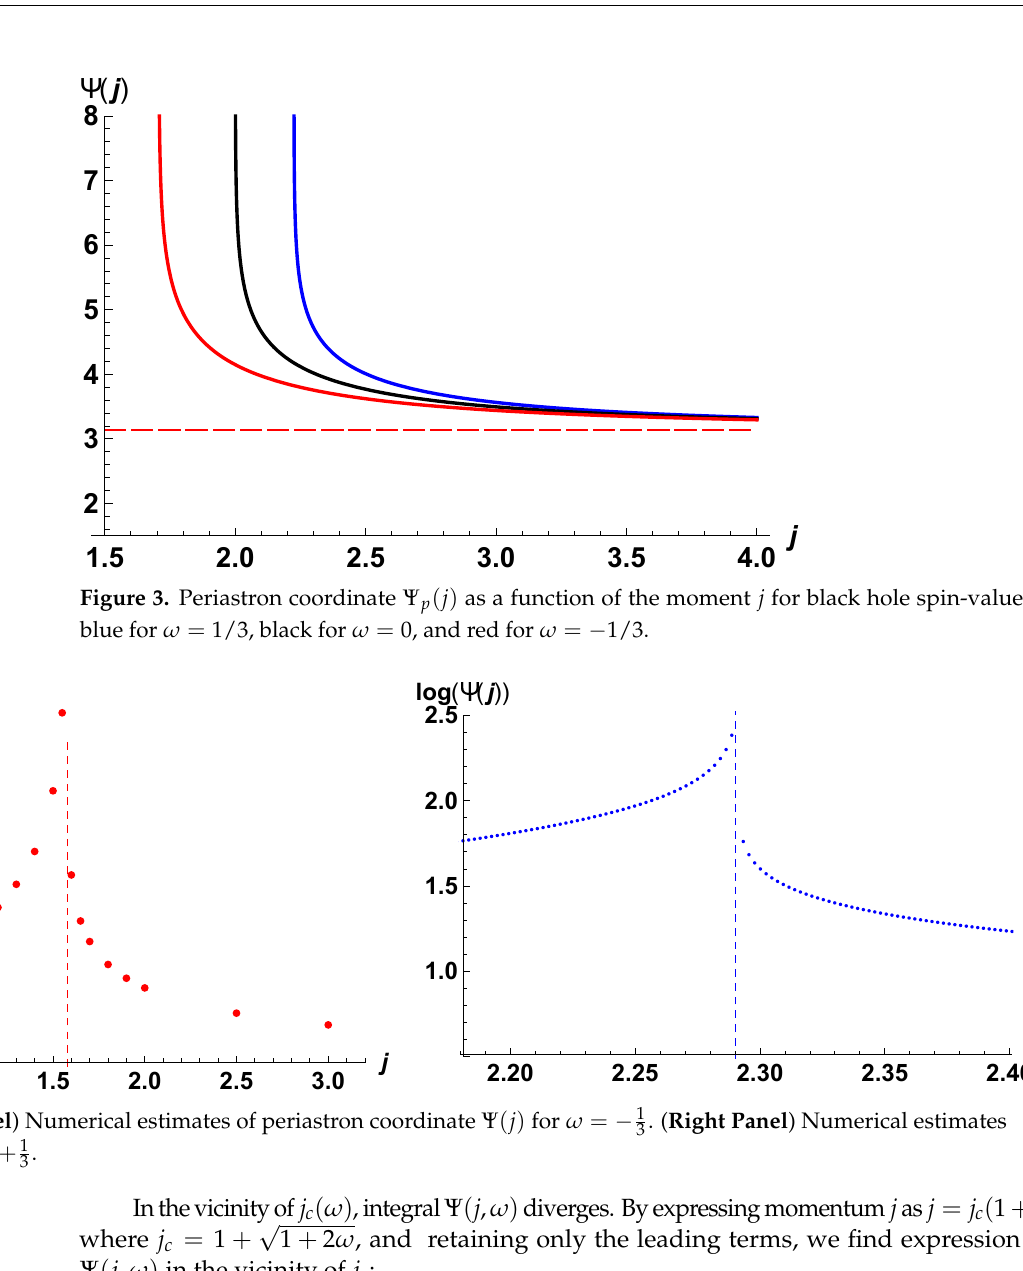
. ( Right Panel ) Numerical estimates 3